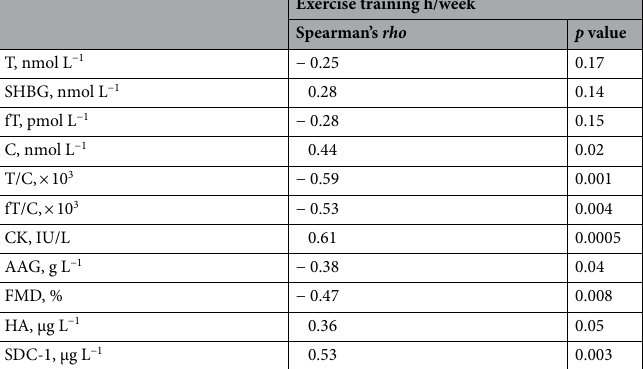
Table 3. Bivariate correlations between training load (expressed as average amount of exercise training in hours per week) and androgen status, biochemical markers as well as endothelial function for all studied subjects (n = 30). Spearman’s rho is given due to non-normal distribution of the exercise training (h/week) data. T testosterone, SHBG sex hormone-binding globulin, fT free testosterone, C cortisol, T/C testosterone to cortisol ratio, fT/C free testosterone to cortisol ratio, CK total creatine kinase, AAG alpha-1-acid glycoprotein, FMD flow-mediated dilation, HA hyaluronic acid, SDC‑1 syndecan-1.